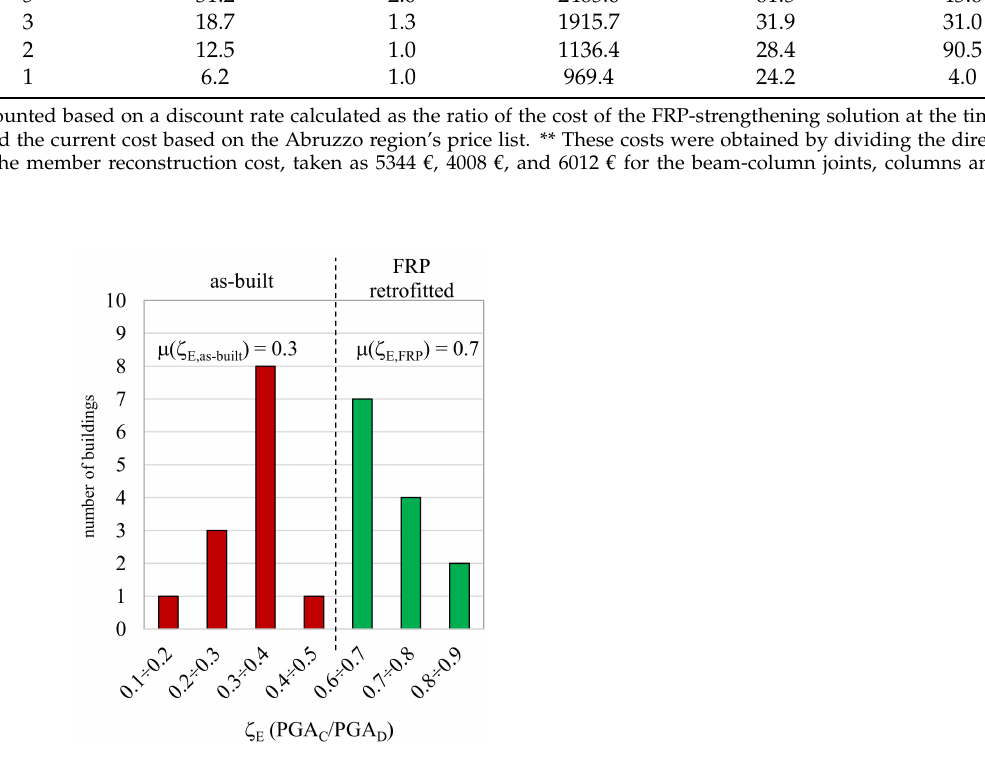
Figure 10. Seismic-safety index at the LSLS for the as-built and FRP-retrofitted